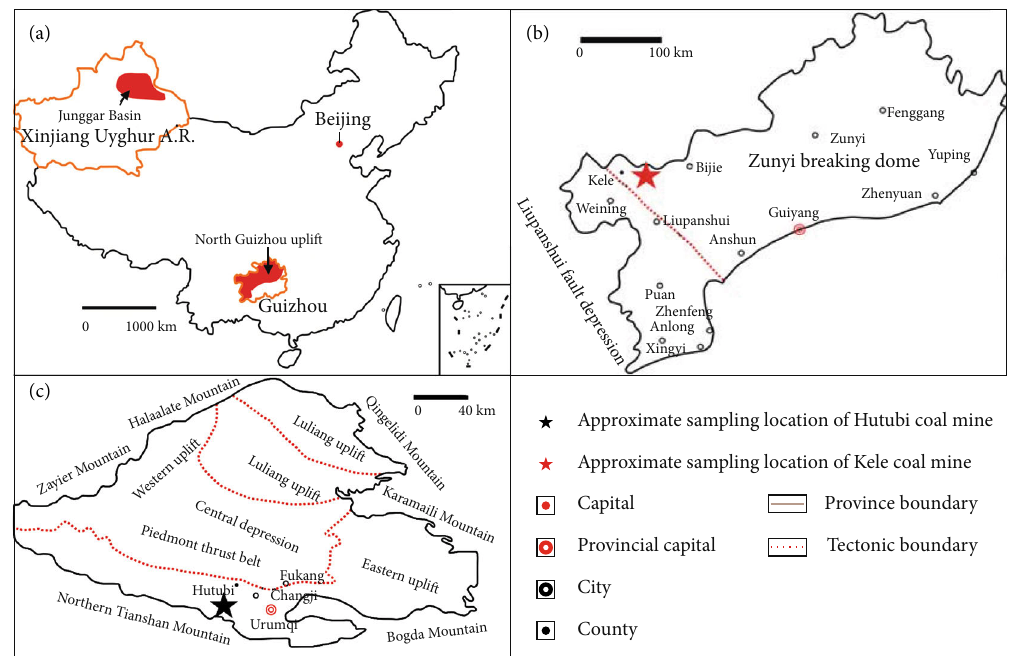
Figure 1: Positions of sampling locations in Kele coal mine (a, b) and Hutubi coal mine (a,